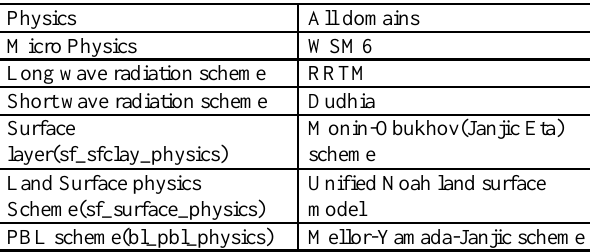
Table 2: Physics options and model